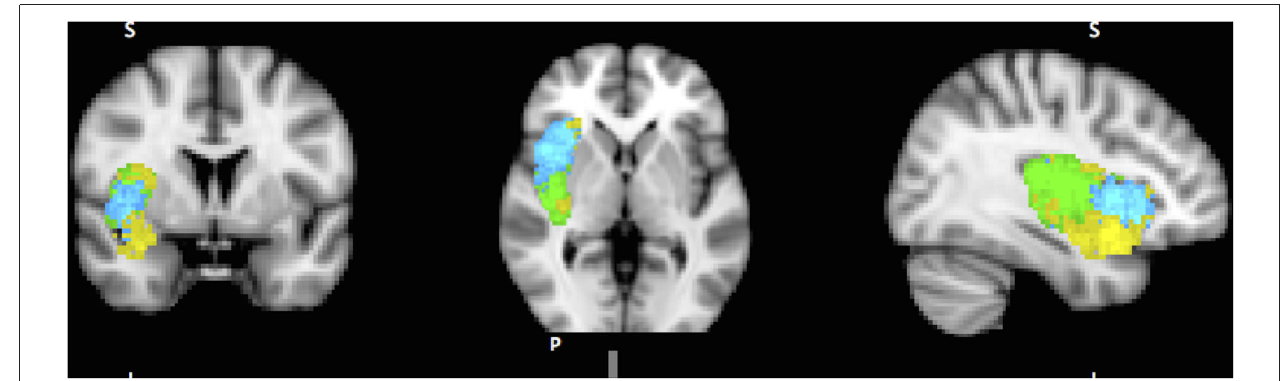
FIGURE 1 | Sub-regions of the Insula: posterior (green), dorsal anterior (blue) and ventral anterior (yellow). Sub-region masks provided by Chang et al. (2012) downloaded from